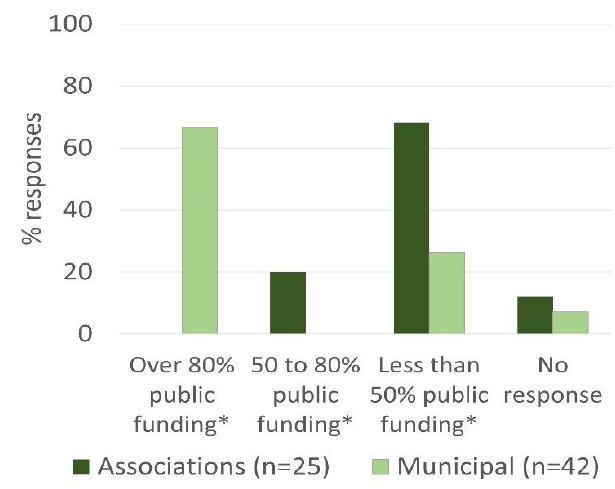
Figure 3. Public funding available to animal shelters. Data gathered by a questionnaire targeted to Municipal and Non-Municipal shelters (Associations) in March/April 2021. * Indicates statistically significant difference between Municipal shelters and Animal Associations (d.f. 1, p < 0.05).